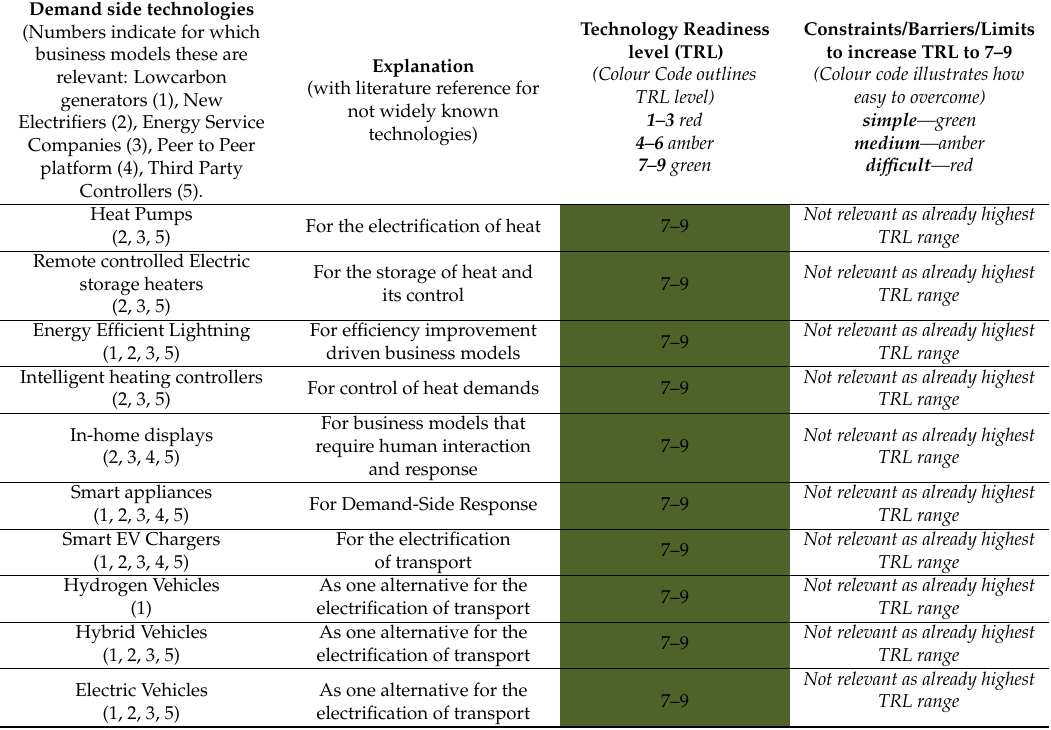
Table 4. TRLs of demand-side technologies.